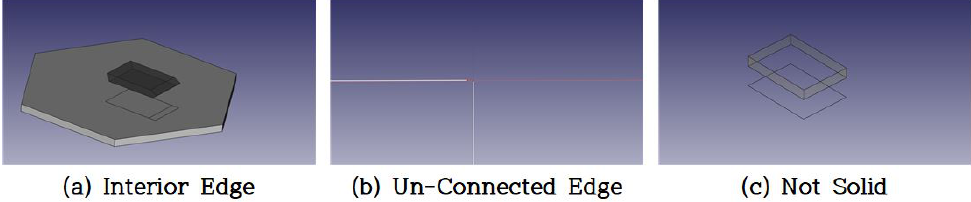
Figure 12. Non-manifold cases caused by incorrect geometric processings: ( a ) The rectangular profile including an interior edge, ( b ) Two un-connected edges projected from the original shape, and ( c ) a failure for extruding broken